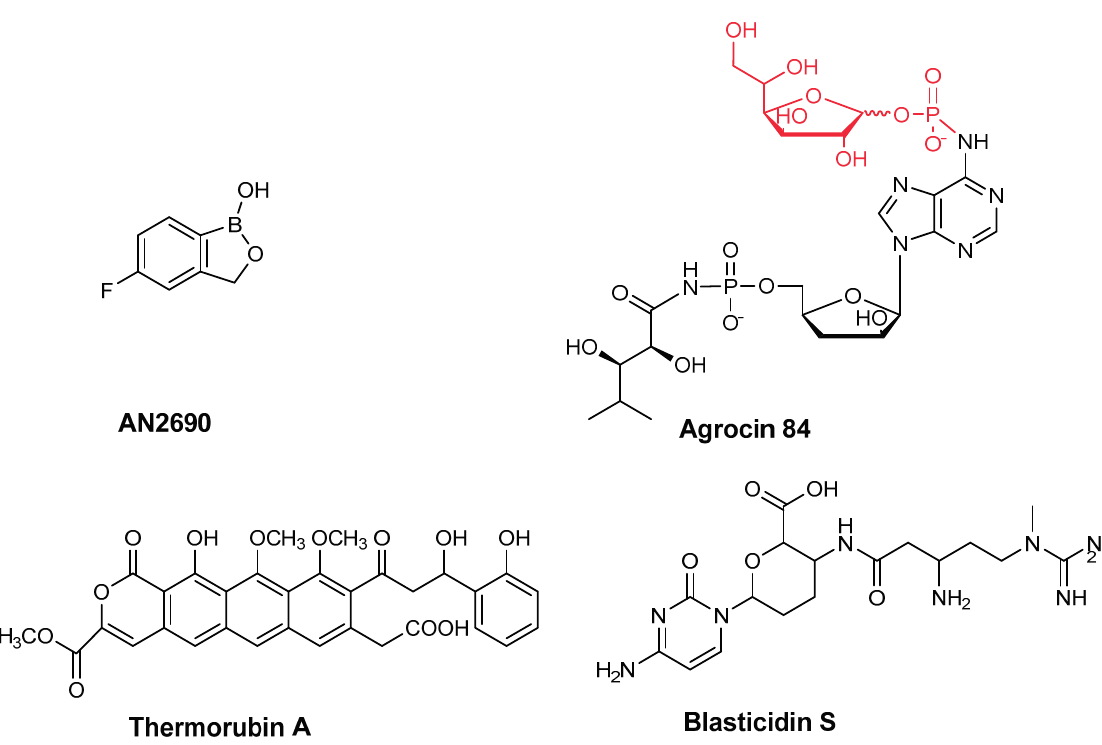
Figure 3. Chemical structures of tRNA based inhibitors of aminoacyl-tRNA synthetases (AN2690 and agrocin 84/TM84) and ribosome (thermorubin and blasticidin